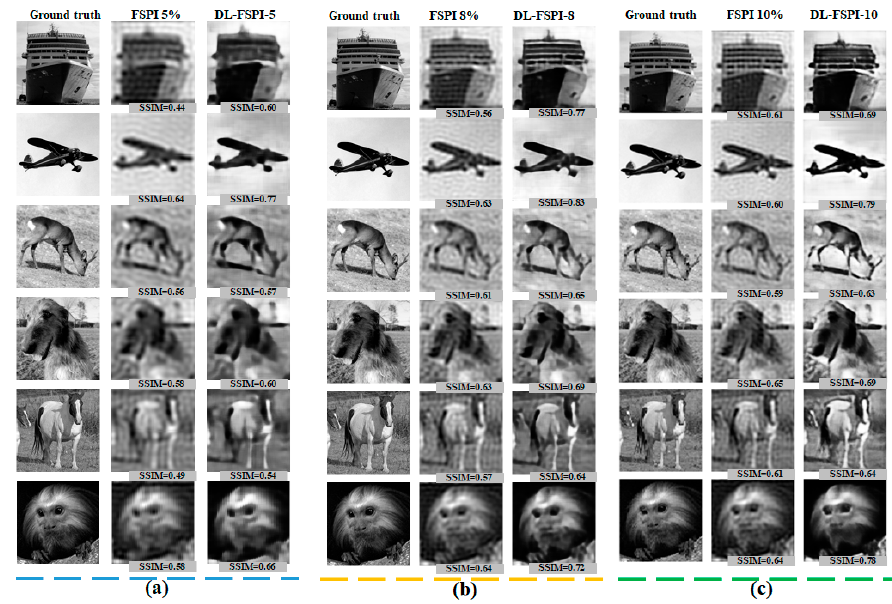
Figure 4. DL-FSPI reconstruction for the validation dataset for ( a ) 5%, ( b ) 8%, and ( c ) 10% sampling rates.